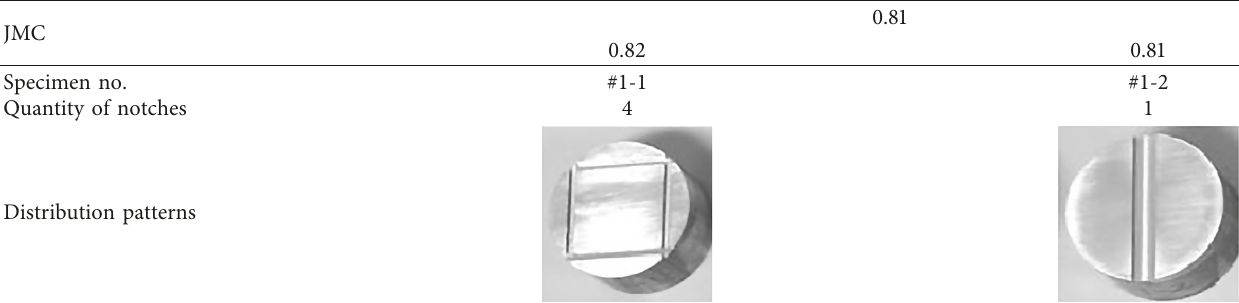
Table 2: Geometrical parameters of the specimens: #Set 1.